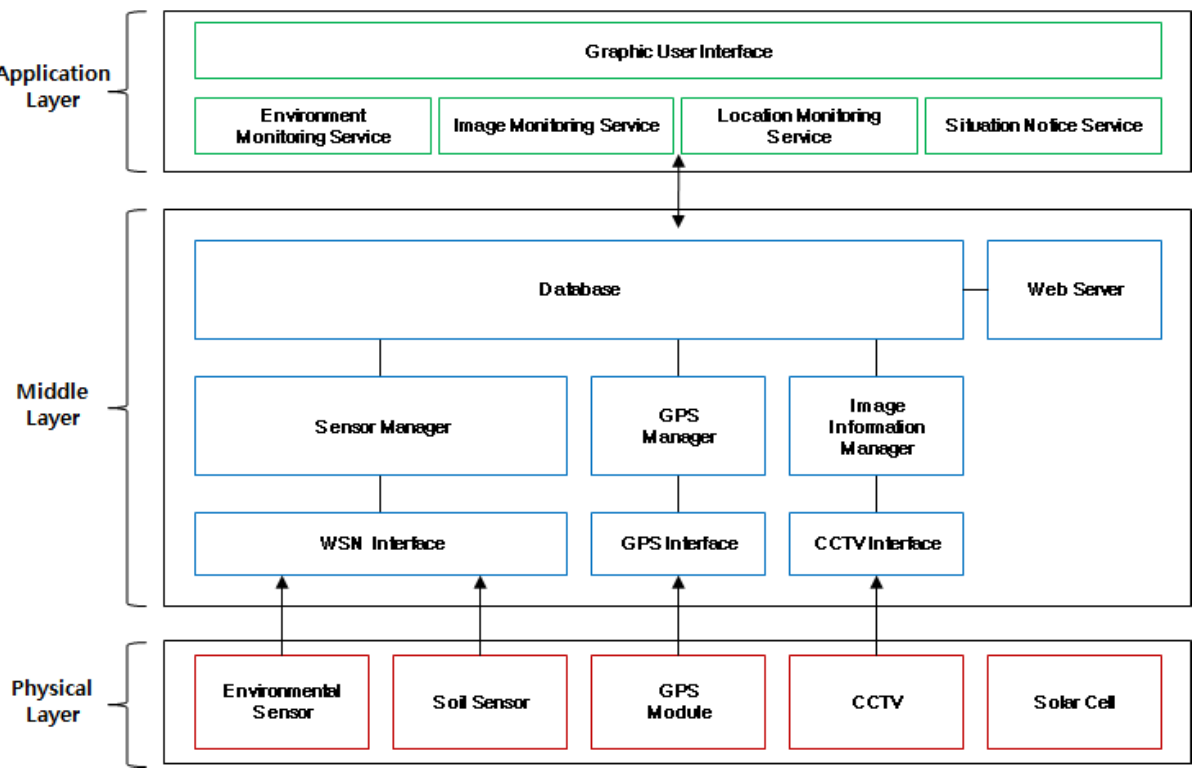
Figure 1. Agricultural Environment Monitoring Server System